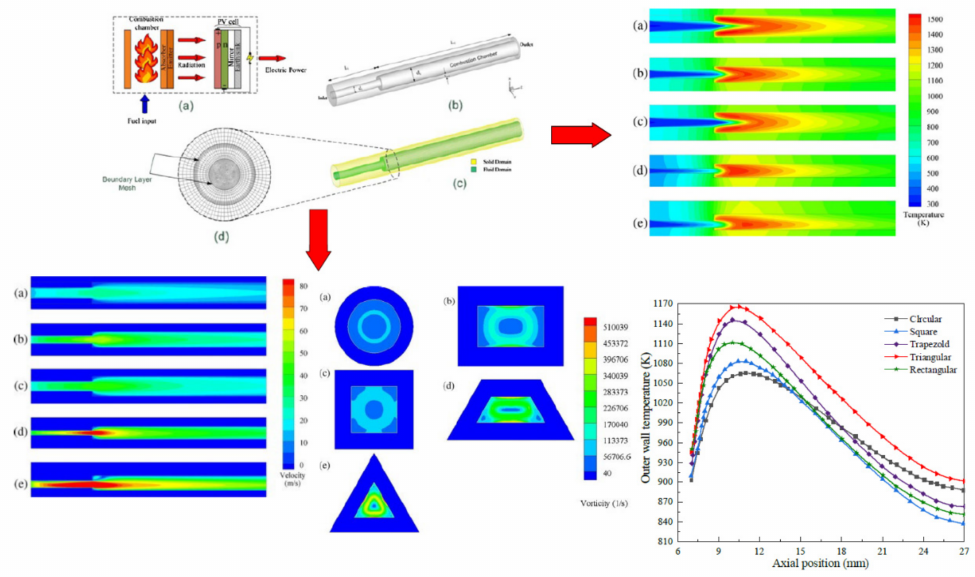
Figure 17. Velocity contours and temperature contours for different